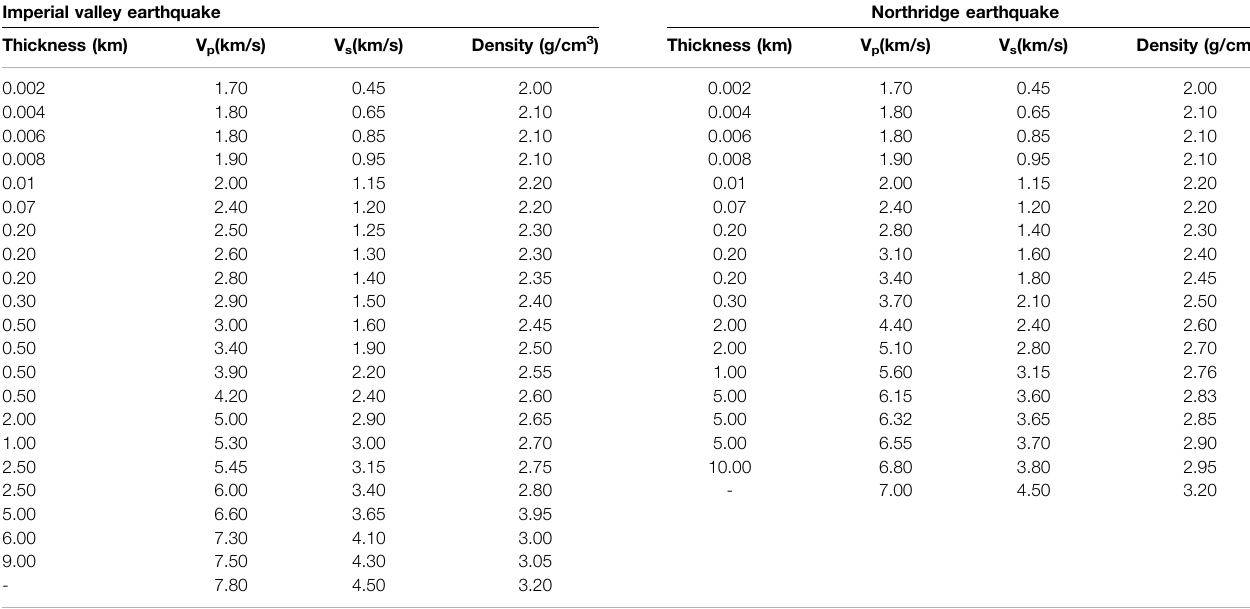
TABLE 1 | Imperial Valley and Northridge region 1-D velocity pro fi les Imperial valley earthquake Northridge earthquake